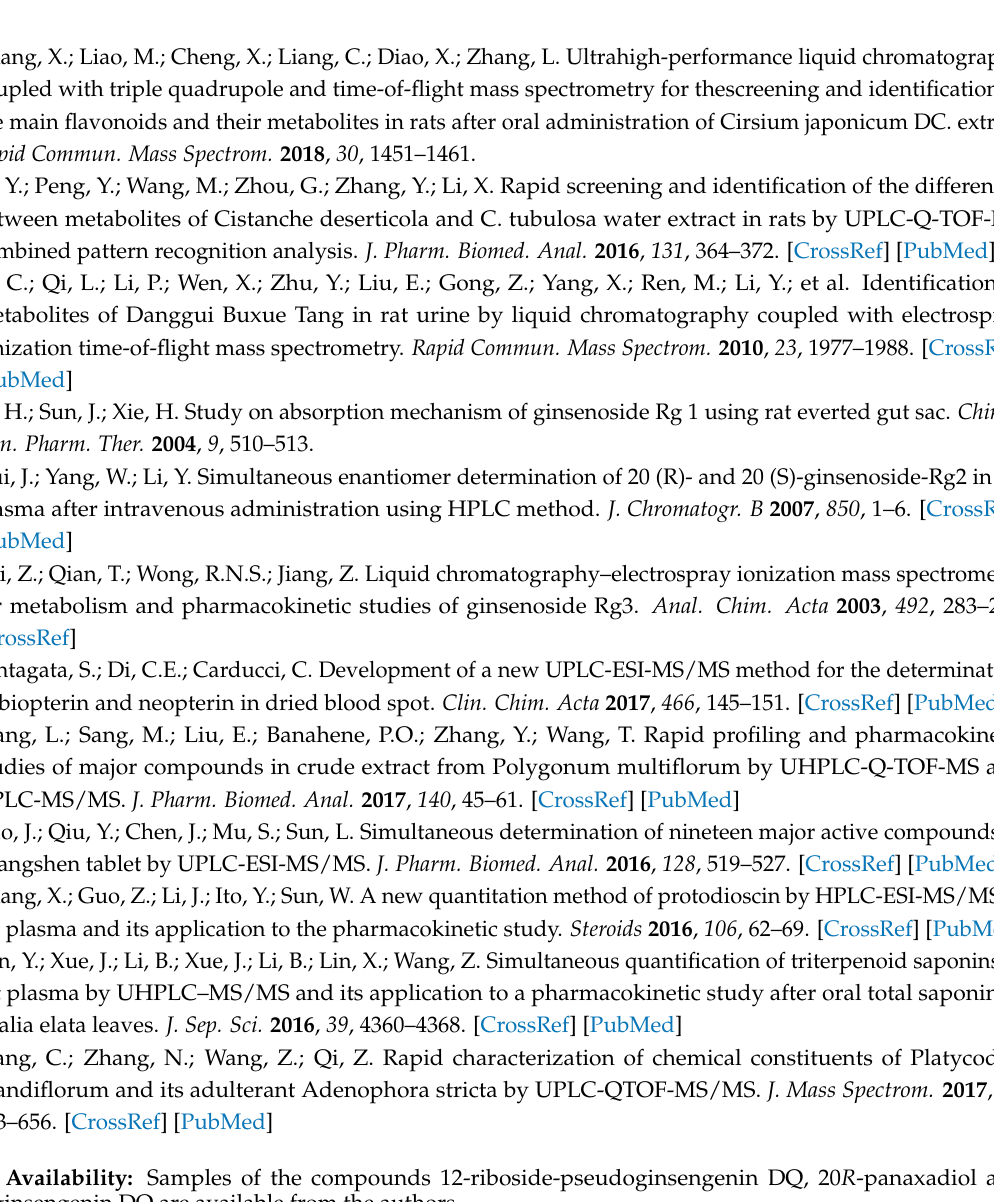
Sample Availability: Samples of the compounds 12-riboside-pseudoginsengenin DQ, 20 R -panaxadiol and pseudoginsengenin DQ are available from the